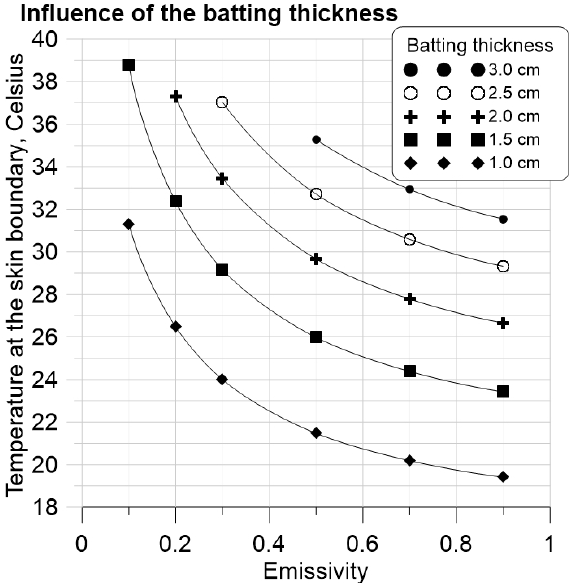
Figure 8. Influence of the IR on the temperature at the boundary between the skin and the undershirt after 120 min. Emissivity of the IR ζ 2 varies between 0.1 and